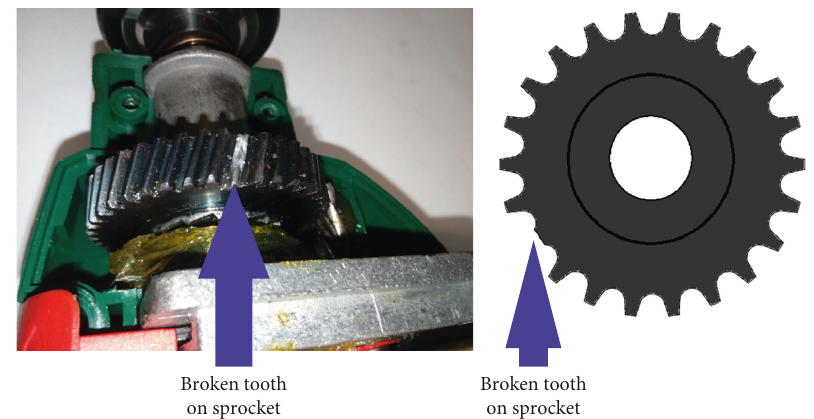
Figure 2: CM with broken tooth on sprocket.